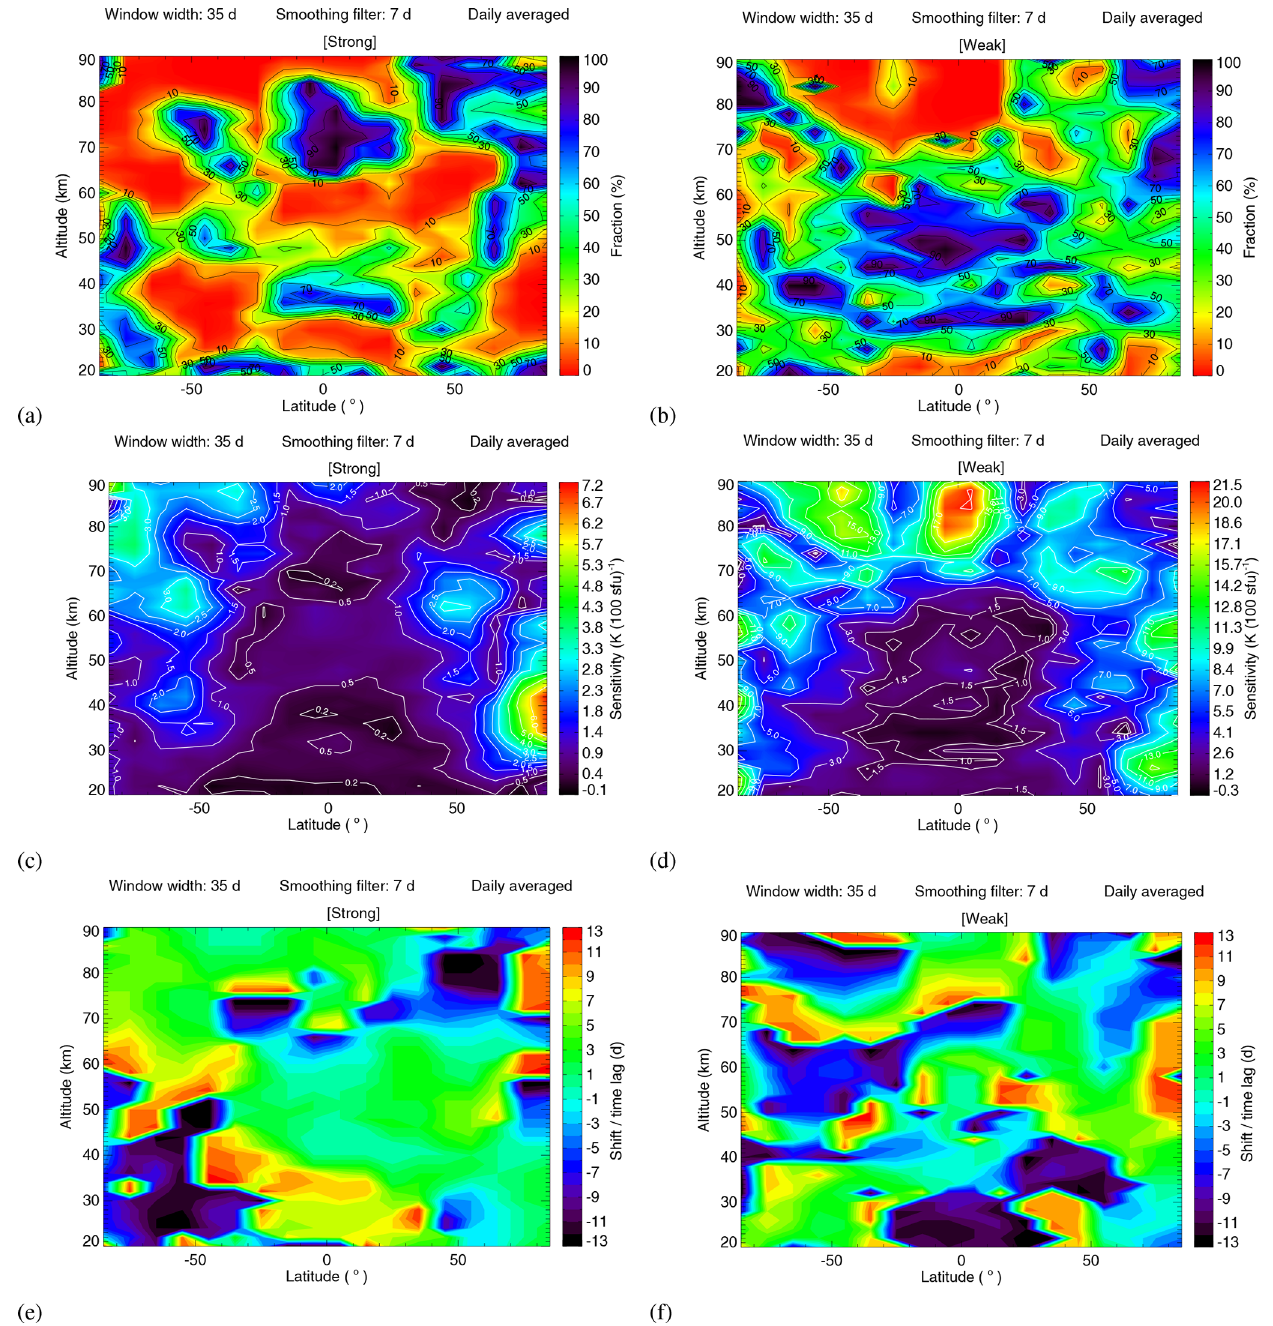
Figure 12. (a–b) Similar to Fig. 9a, except for strong and weak solar activity years. (c–f) Sensitivity and shift for latitudes from 85 ◦ S to 85 ◦ N and altitudes from 20 to 90km for different solar